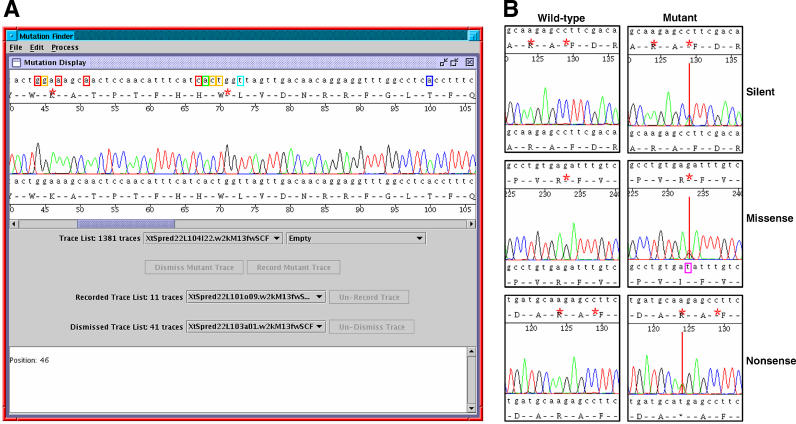
Mutation DetectionAll sequences generated by TILLING (see Figure 7) are examined and compared to a reference sequence by a Mutation Finder program. Any disparities with reference sequences are recorded for view in a Mutation Display window (A). Reference DNA and amino acid sequence is displayed above the trace and the TILLING trace below. Boxes around reference sequence nucleotides denote alterations in one or more TILLING traces; box color indicates number of traces altered. The asterisk above the reference amino acid sequence designates a position at which a mutation has been visually confirmed and recorded. Clicking on a box or asterisk will recover the trace(s) containing the change. Traces that are not confirmed are dismissed. All processed traces are accessible via the pull down trace lists. Examples of mutations are displayed for silent, missense, and nonsense alongside wild-type traces for comparison (B).